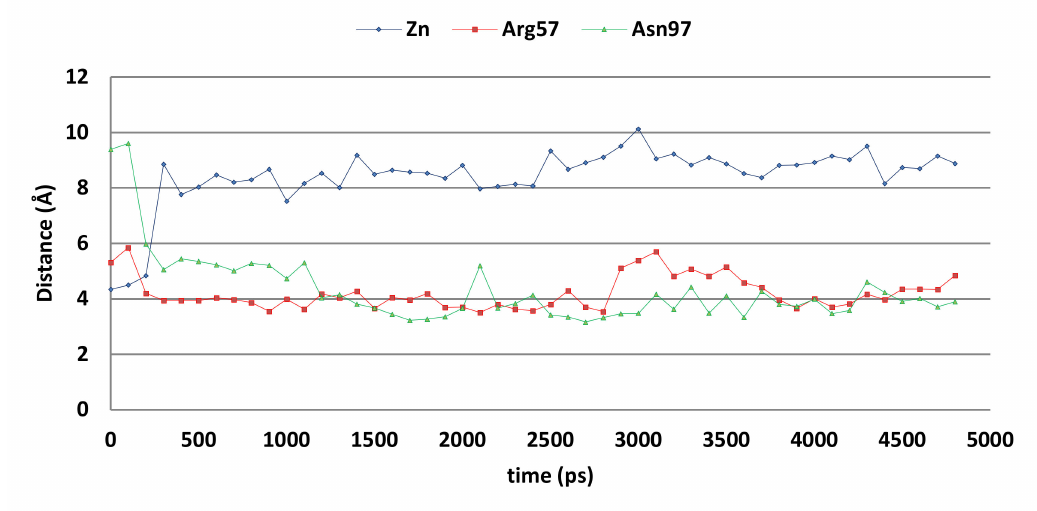
Figure 9. The distances between compound 5k and the zinc ion (blue), Arg57 sidechain (red), and Asn97 side chain (grey) of the CgNce103 active site during the 5-ns MD